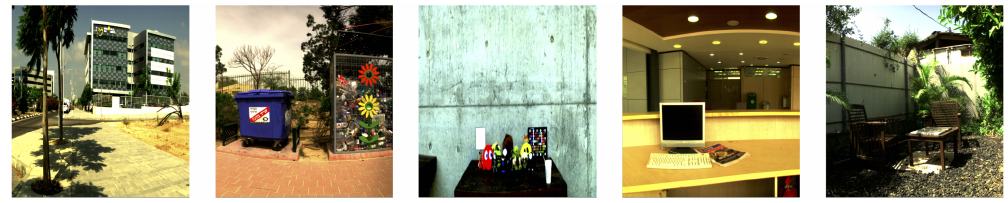
Figure 9. Example scenes from the ICVL hyperspectral image database